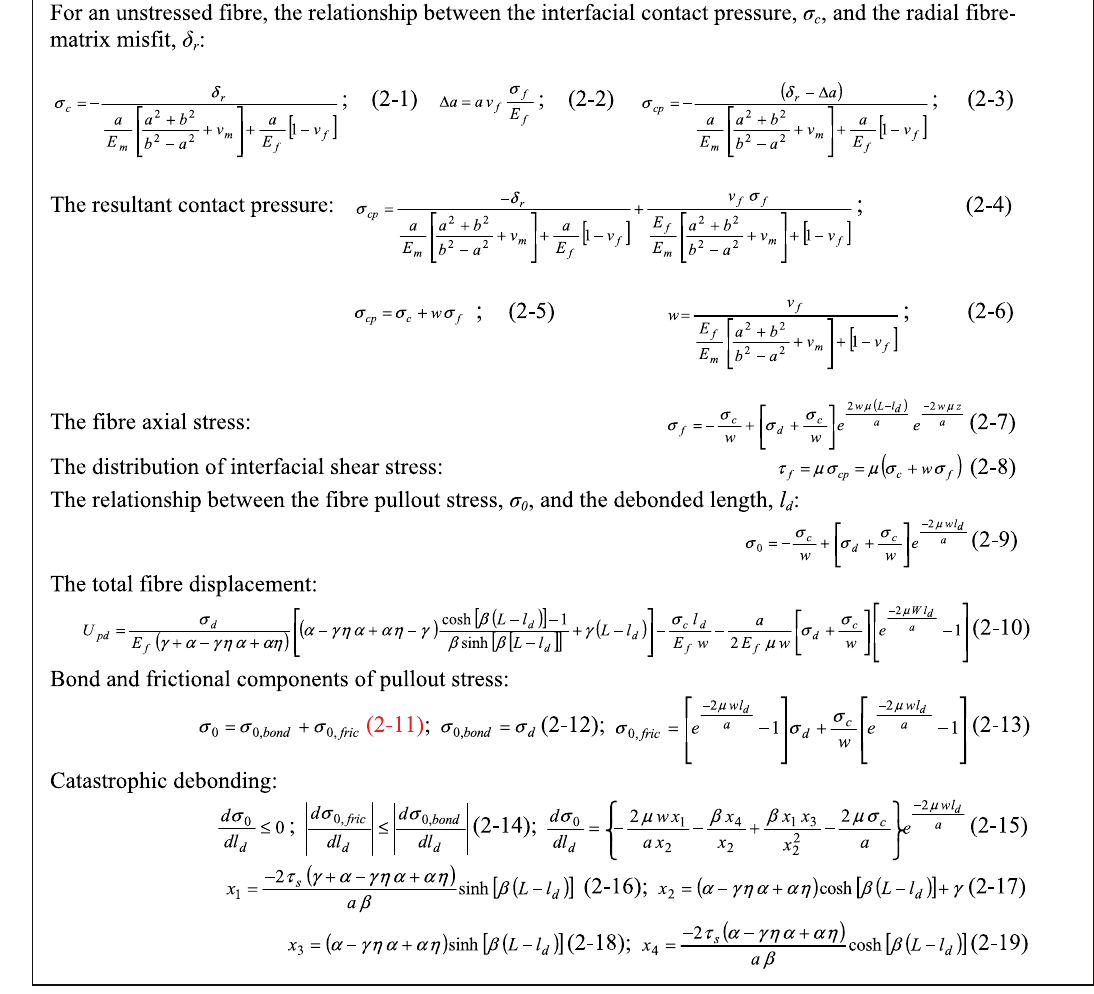
Figure 2. Stage 2 – fiber partially bonded along its embedded length with the relevant